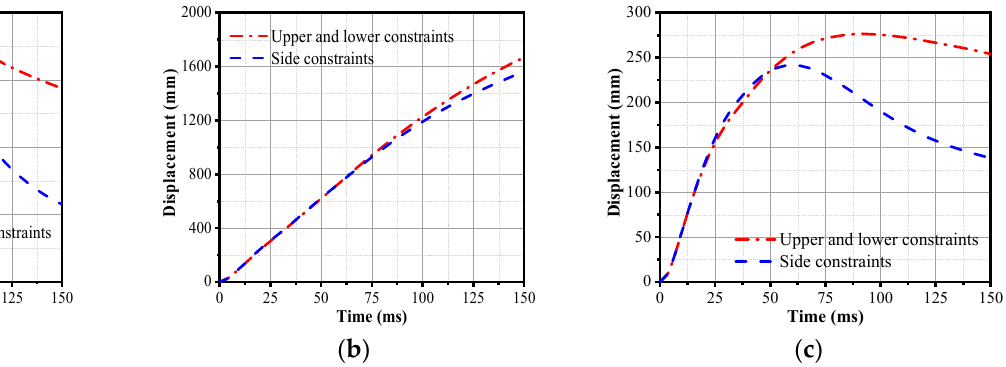
Figure 12. Influence of boundary constraints at the SPUA layer to wall center displacement-time histories under different loadings: ( a ) Load 1; ( b ) Load 2; ( c ) Load 3. The damage morphology of the four-sided constrained CMU walls with a SPUA- retrofitted layer is shown in Figure 13, where the right side in each image is the back side, blue is the CMU masonry infill wall, and yellow is the SPUA-retrofit layer. It can be seen that under Load 1, although the resilience of the wall was increased after the four-sided restraint of the polyurea reinforcement layer, the increase in the restraint of the polyurea layer increases the binding force on the four sides of the wall, resulting in more severe fragmentation of the blocks at the left and right ends of the wall. Under the action of Load 2 with greater peak overpressure, as the SPUA-retrofitting layer is prone to tearing at the boundary, not only does the boundary construction of the SPUA-retrofitting layer with four fixed sides have relatively little effect on the overall dynamic response of the wall, but in examining the damage pattern, the increase in the tearing of the SPUA-retrofitting layer reduces its integrity and protective ability against splash debris. Therefore, the boundary constraint of the enhanced polyurea reinforcement layer usually has a limited effect on the improvement of the blast resistance of the wall, while there is a side effect of increasing the local damage of the wall.